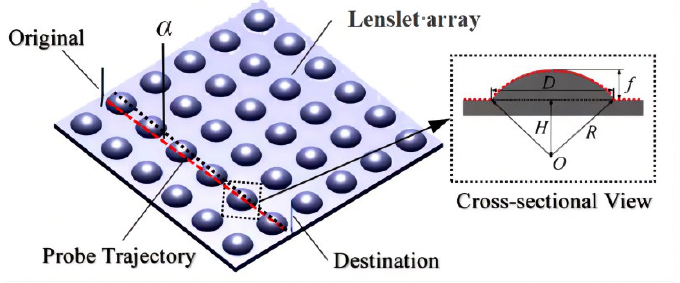
Figure 2. Relationship between lenslet array and off-axis trajectory of stylus. For an ideal spherical lens, the distance H (cardinal distance) from the center of the circle to the base of the lens is equal for trajectory arcs with different off-axis degrees, and the center of the arc circle of the trajectory with different off-axis degrees forms a line segment parallel to the base of the lens (circle center line), which is shown in Figure 3.